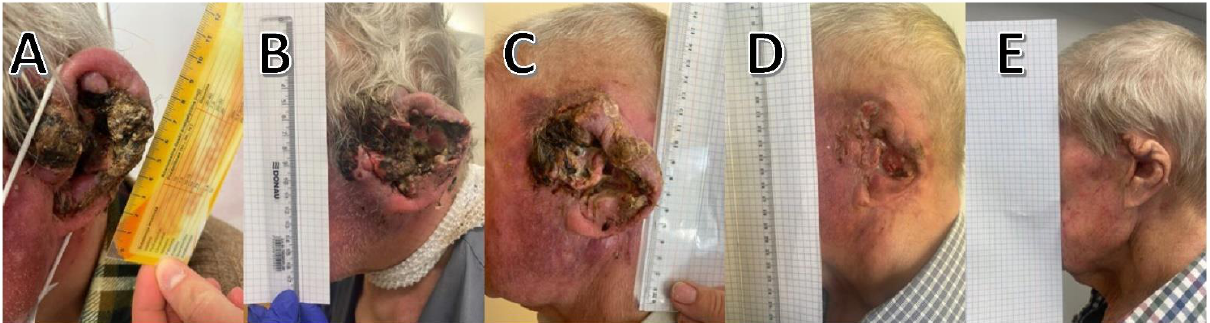
Figure 1. ( A ) Rapidly growing cutaneous mass on the patient’s right ear, visible infiltration of the tissues of the right cheek; ( B ) ulcerative mass prior to therapy; ( C ) healing ulcer base with scarring after one dose (3 weeks) of cemiplimab; ( D ) lesion after 3 doses (9 weeks) of cemiplimab; ( E ) com- plete response after 18 weeks of cemiplimab (6